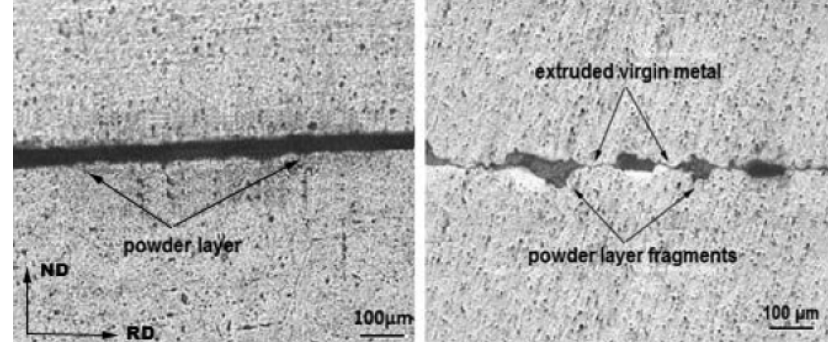
Fig. 3. The light micrographs of (a) initial stack and (b) after the second pass of rolling.